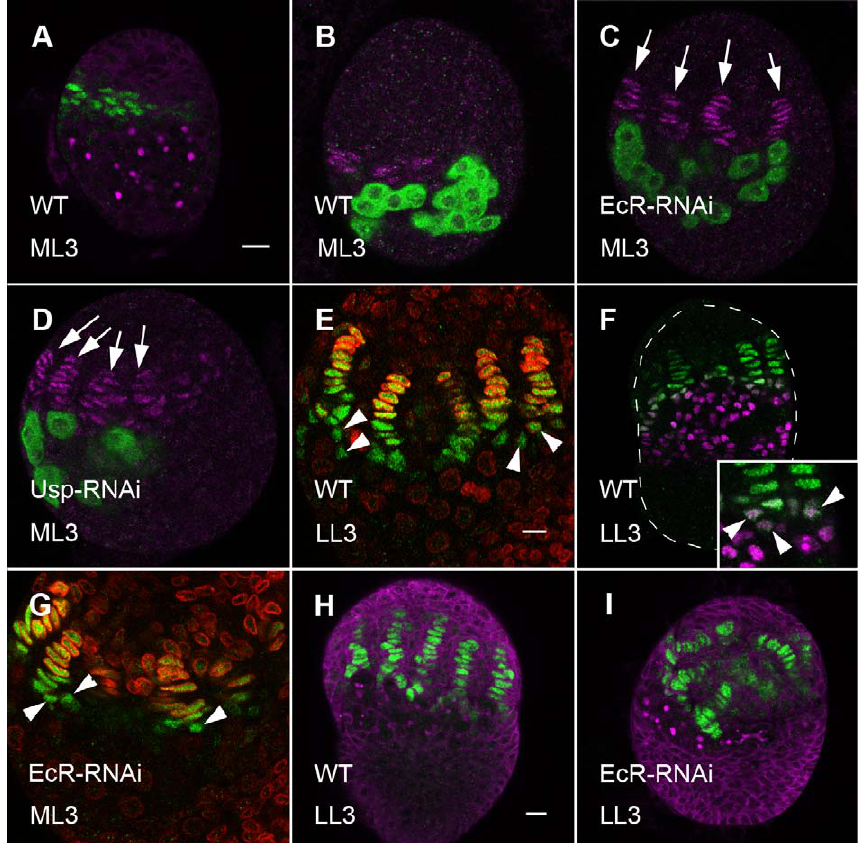
Figure 2. Ecdysone receptors repress precocious niche formation. (A, B) Terminal filaments of wild-type ML3 ovaries are labeled either by hh - lacZ (A, green) or anti-En (B, magenta). Few TF cells which are unorganized, or organized into short filaments, can be seen. Germ cells are marked by round fusomes (A, 1B1 antibody, magenta) or by anti-Vasa (B, green). (C, D) In EcR -RNAi (C) or usp -RNAi (D) ML3 ovaries, more TF cells and more organized filaments can be seen (anti-En, magenta, arrows). Germ cells are labeled by anti-Vasa (green). (E–I) hh -lacZ (green) marks all TF and cap cells. (E) In WT LL3 ovaries TF cells are distinguished by hh -lacZ staining and oval-shaped nuclei. LaminC (red) is only apparent in older TF cells, at the anterior of each TF stack. Cap cells (arrowheads) are at the posterior base of TF, have rounder nuclei, and do not yet stain with anti-laminC. (F) Anti-Tj (magenta) labels ICs. Cap cells that form at the base of TFs are co-stained with hh -LacZ and anti-Tj (inset, arrowheads). (G) EcR -RNAi ML3 ovaries. Unlike wild-type, Cap cells appear already at ML3 (arrowheads). (H, I) Somatic cells and fusomes are labeled by 1B1 (magenta). (H) TFs are regularly spaced in the anterior half of the wild-type ovary. (I) In EcR -RNAi LL3 ovaries, TFs are mis-positioned, with fewer cells between stacks. Bars in (A), (for A–D), in E (for E, G), and in H (for F, H, I) are 10 m